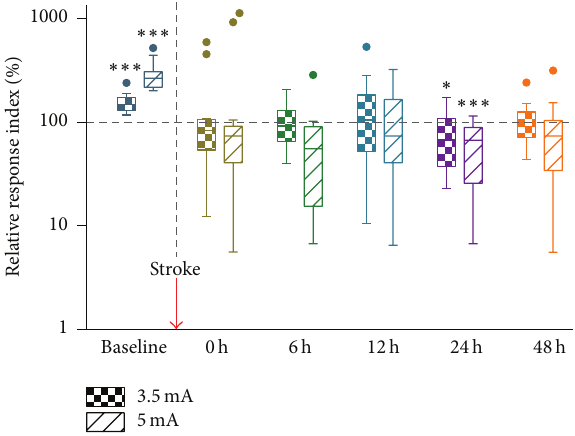
Figure 6: Box-and-whisker plot (Tukey) of relative responses at different time points (baseline, and 0h, 6h, 12h, 24 h, and 48h after stroke). The relative response is calculated by normalization to the responseto2 mAstimulation.Thehorizontaldashlinestandsforthe response to 2 mA stimulation, and the vertical dash line represents the time for stroke induction. Error bars represent SEM ( ∗ 𝑝 < 0.05 ; ∗∗∗ 𝑝 < 0.001 , paired 𝑡 -test compared with 2